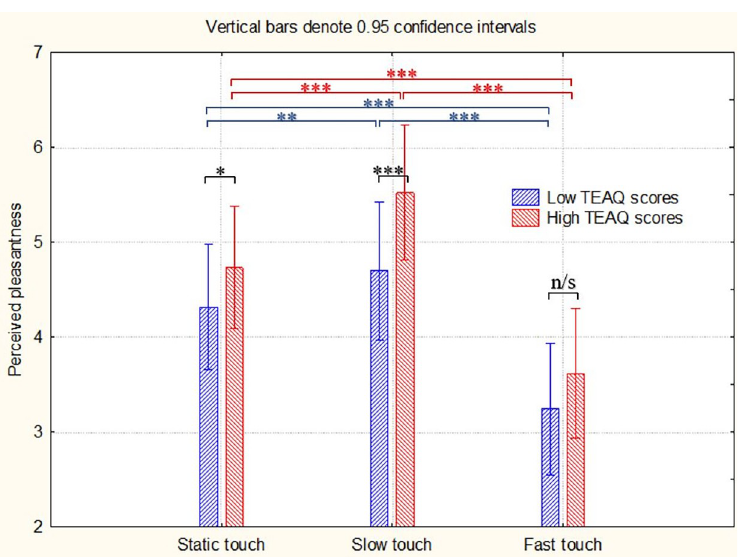
Fig 3. Perceived pleasantness ratings of touch videos for participants with low and high total TEAQ-37 Rus scores. Stars indicate significance levels in post hoc tests ( � : p < .05, �� : p < .01, ��� : p < .001).